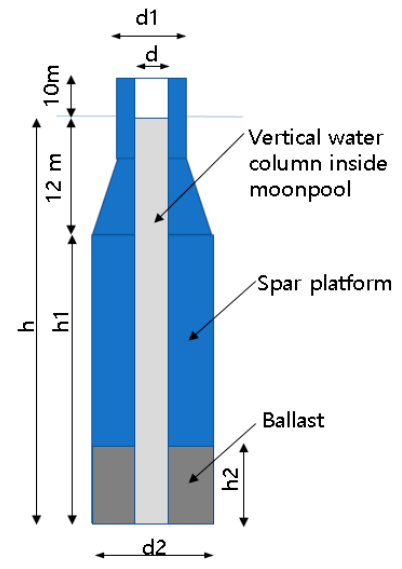
Figure 4. Main dimensions of spar-type platform combined with a moonpool.